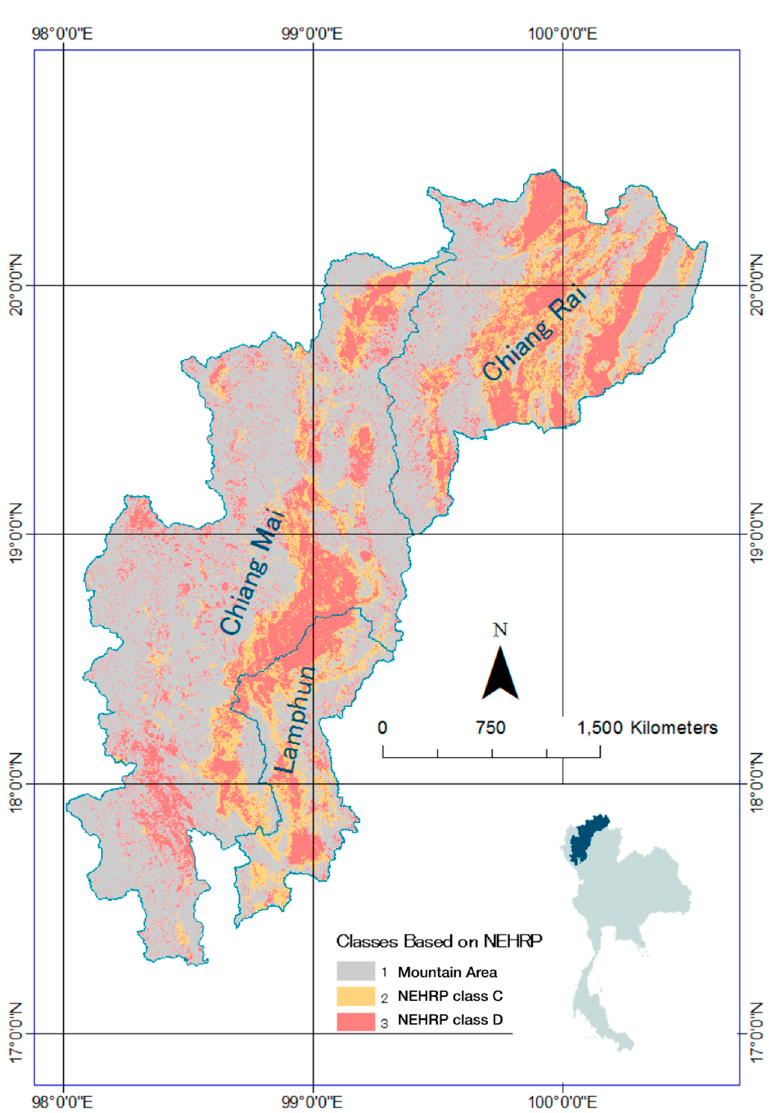
Figure 9. V S30 map based on the reclassified geomorphological map with NEHRP soil characteristic Figure 9. V S30 standards.